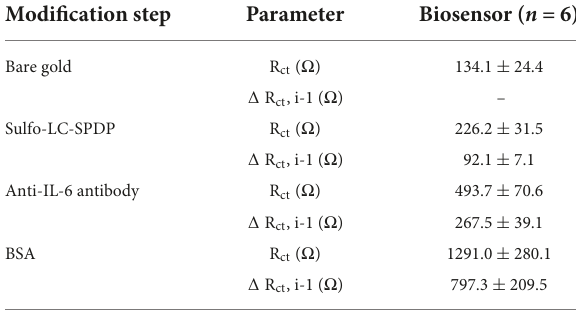
TABLE 2 Charge-transfer resistance values (Rct) and variations between the consecutive functionalization steps (Rct,i-1) with the respective standard